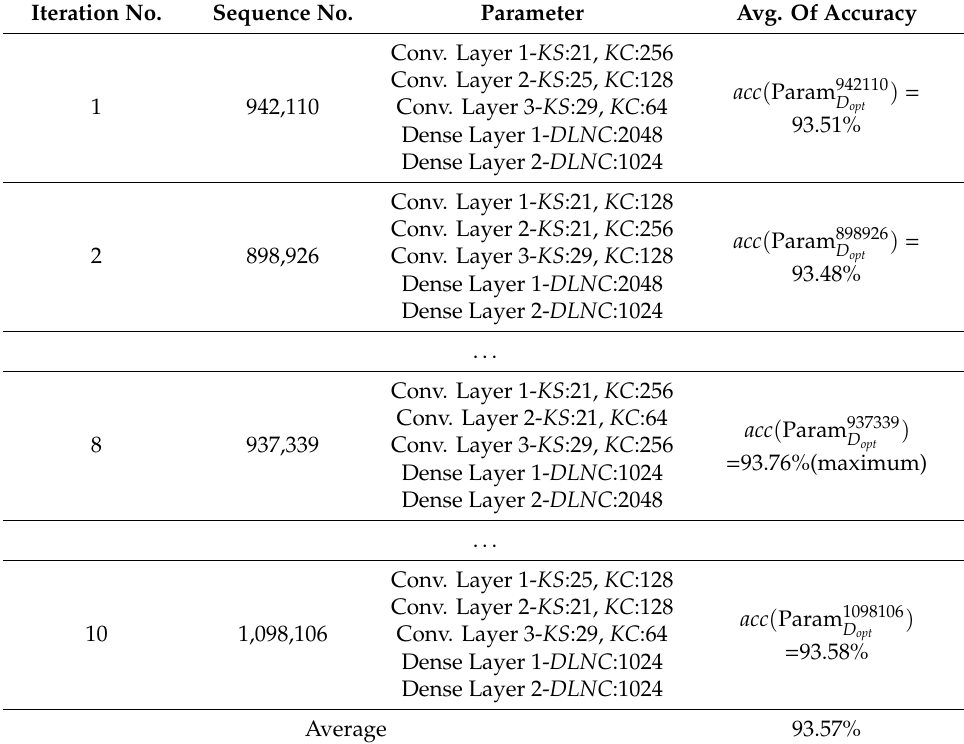
Table 4. For 10 times repeated learning, the combination of parameters having the maximum recognition rate for each iteration.